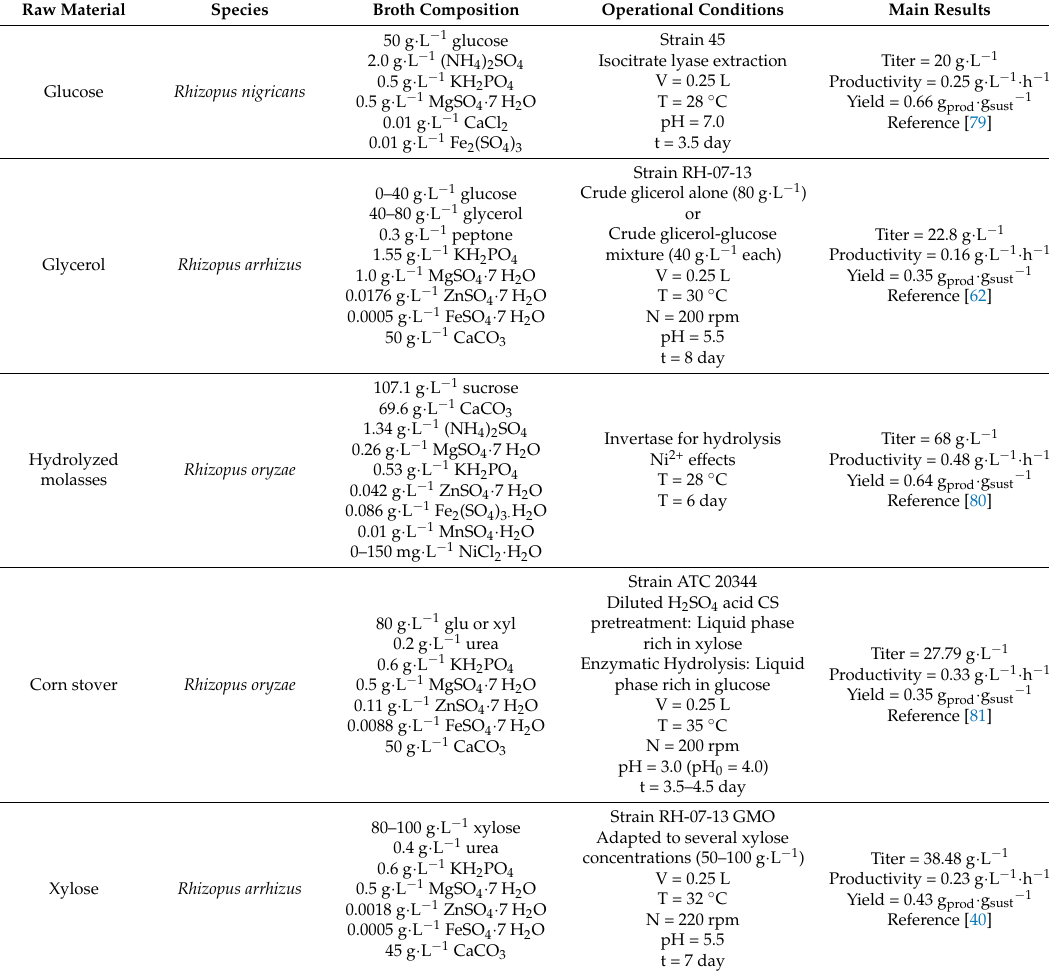
Table 2. Main results in batch shaken flasks (orbital